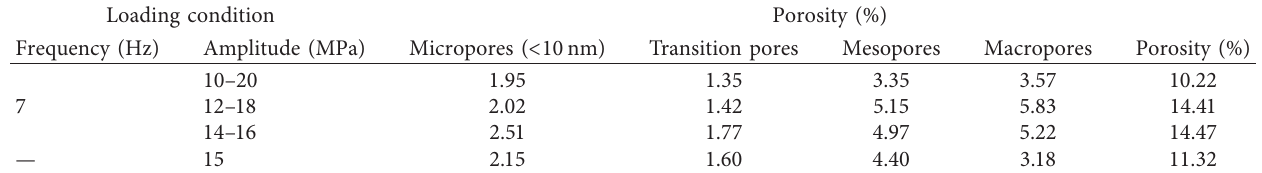
Table 4: Percentages of the pore volume and porosities of coal mass at different loading amplitudes.